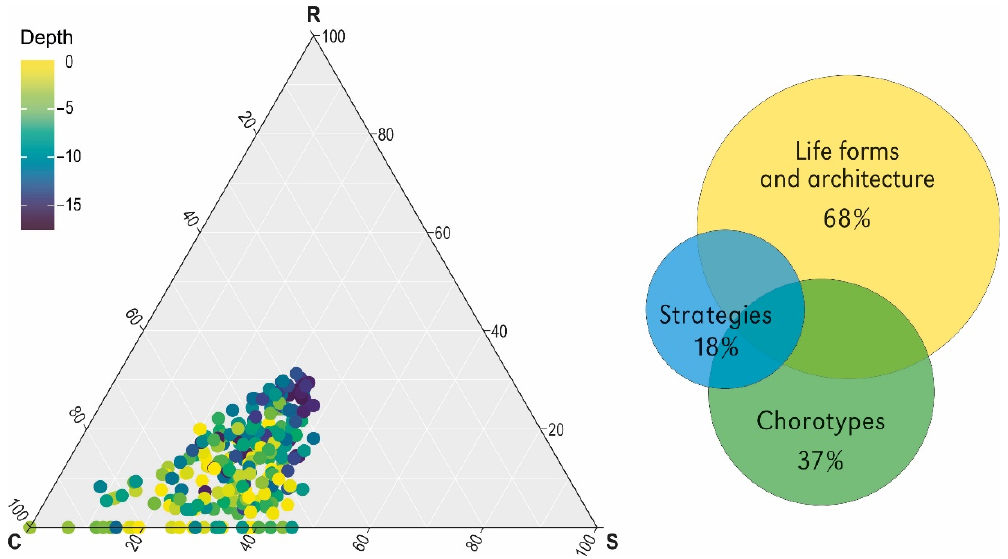
Figure 6. The CSR signature of plots ( left ) presents the position of plots in the CSR triangle. The Venn diagram ( right ) presents the explanatory power of explanatory variables. The explanatory powers overlap. Strategies alone explain only 8 % of the explained variation, while plant functional traits (life forms and architecture) alone explain 50 %, and chorotypes 23%.